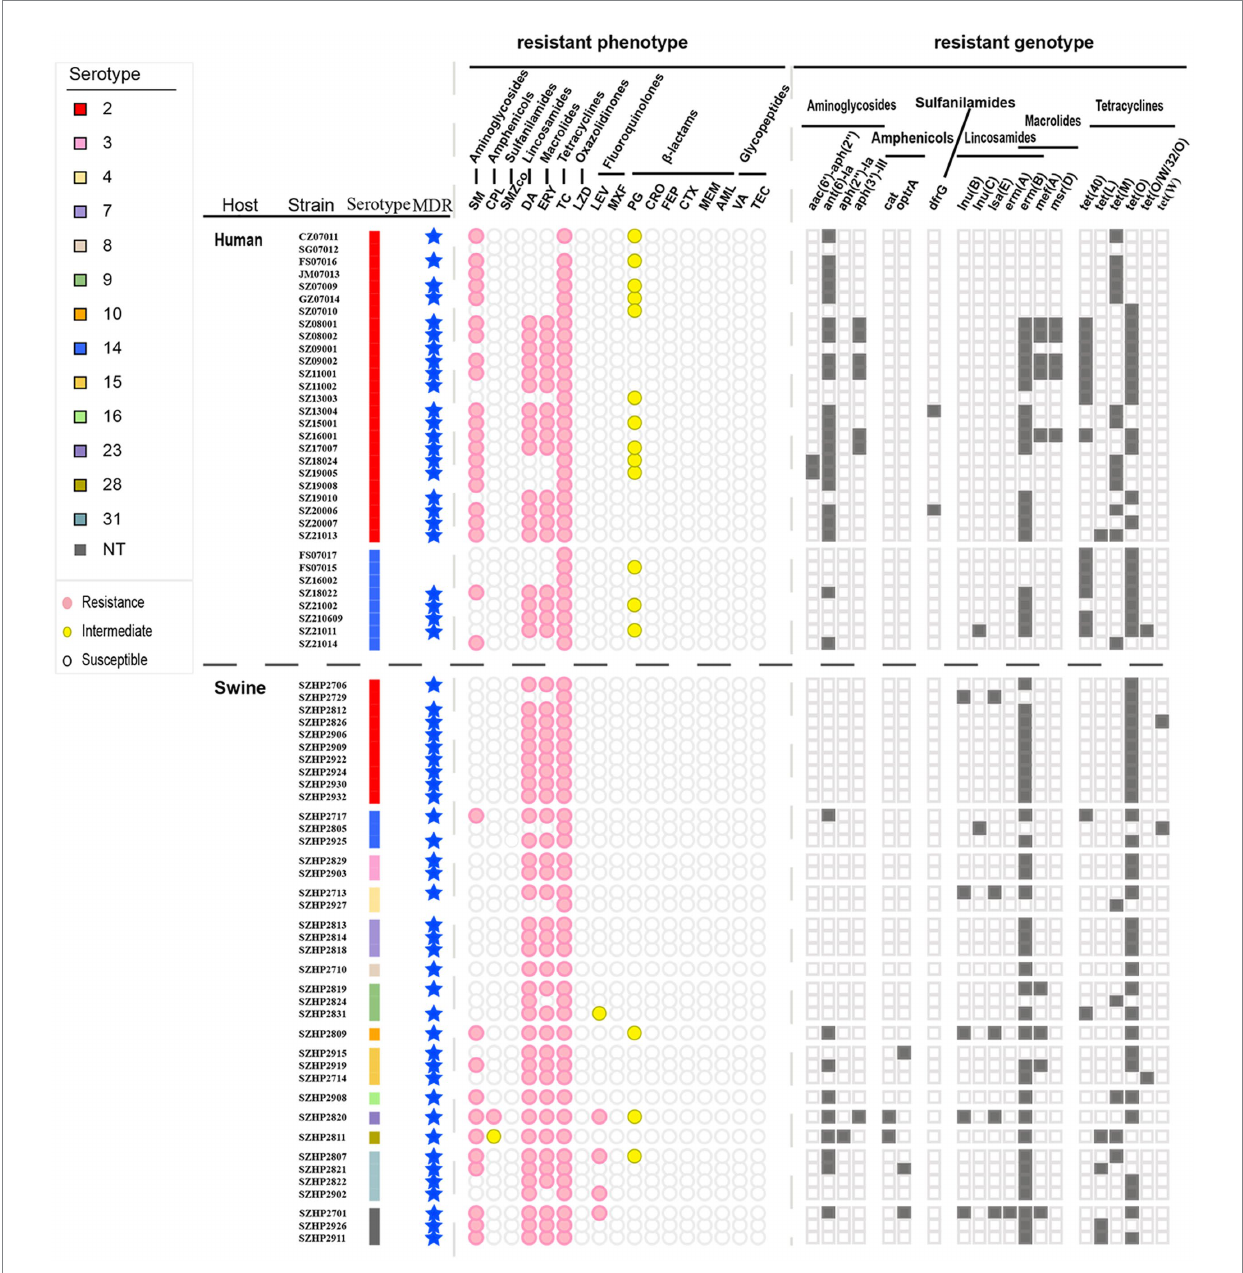
FIGURE 6 Different serotypes of Shenzhen S. suis isolates with resistance phenotype and resistance genotype distribution. MDR = multiple drug resistance. Circles or squares are filled with color when the corresponding resistance phenotype or resistance genotype is